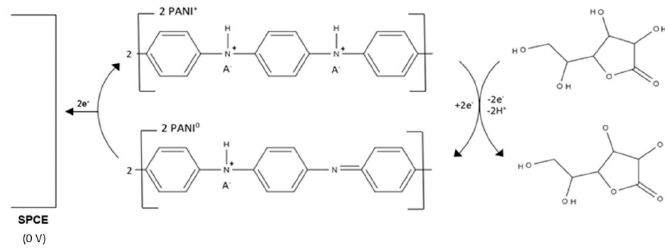
Figure 4. The reaction scheme of L-ascorbic acid at a polyaniline (PANI)-SPCE. Adapted from [40].